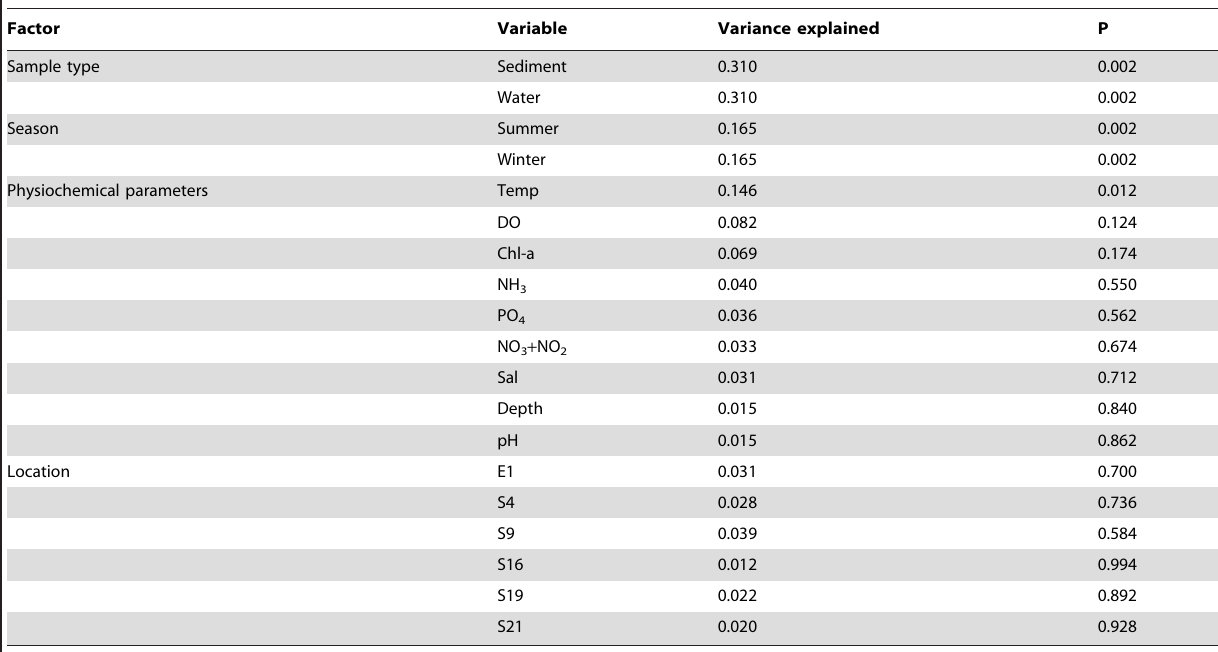
Table 2. Summary of